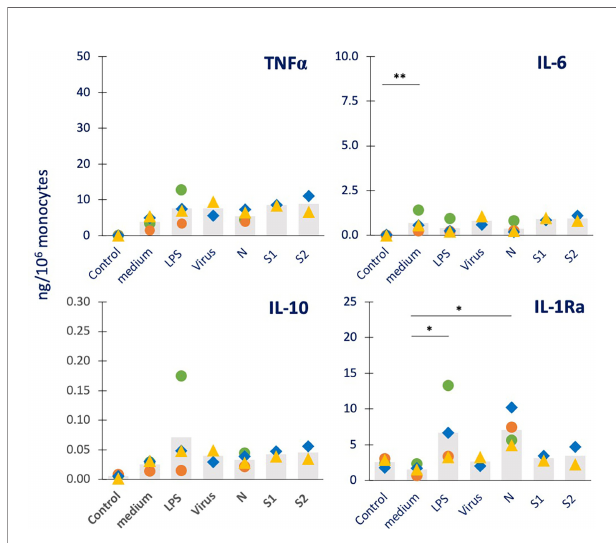
FIGURE 2 | Innate immune memory response to a bacterial challenge in human monocytes primed with inactivated SARS-CoV-2 or its proteins. Human monocytes isolated from blood of four individual donors (green, red, blue, and yellow symbols) were cultured for 24 h in culture medium alone (column “ medium ” ) or containing LPS (1 ng/mL, positive bacterial control, column “ LPS ” ), the inactivated SARS-CoV-2 virus (5 x10 5 copies, column “ virus ” ), N, S1, or S2 (all at 1 µg/mL; columns “ N ” , “ S1 ” and “ S2 ” ). Cells were then washed and rested for 7 days in the absence of stimuli, then challenged for 24 h in fresh medium alone (column “ control ” ) or containing 5 ng/mL LPS. The column “ control ” values from cells that received no challenge are included in each panel as “ control ” and encompasses the values from primed and unprimed cells that received no challenge, i.e., fresh medium alone. These values did not differ between primed and unprimed cells, con fi rming the return to baseline after the resting period. The production of TNF a (upper left), IL-6 (upper right), IL-10 (lower left) and IL-1Ra (lower right) was measured in the 24 h supernatants by ELISA. Data are presented as individual donors ’ values (colored symbols) and as mean of the individual values (grey columns). Statistical signi fi cance: * p < 0.05; ** p <